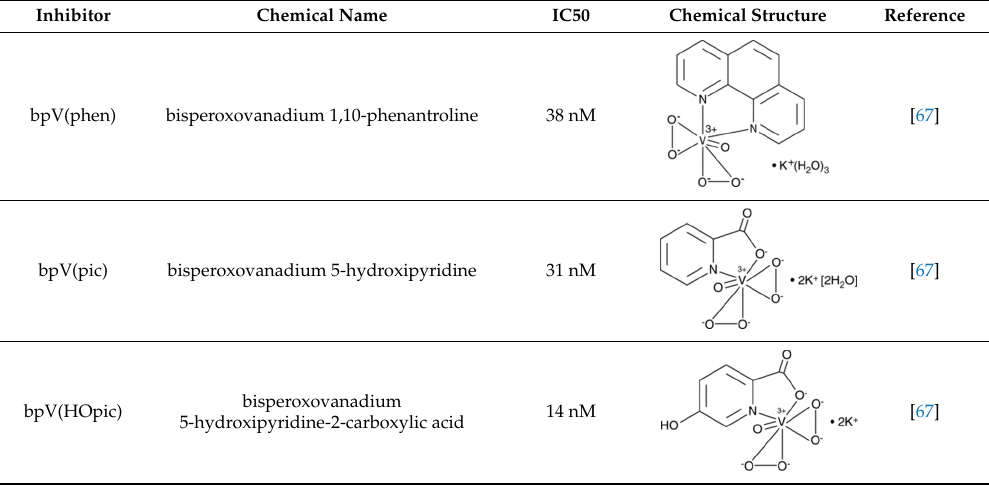
Figure 2. Significance of PTEN inhibition in human disease therapy. Human diseases which could benefit from PTEN pharmacologic inhibition are indicated (see text for a more comprehensive description). Note that the potential beneficial effect of PTEN inhibition has been related with PTEN PI(3,4,5)P3 lipid phosphatase activity. Whether PTEN inhibition may be beneficial in some conditions in relation to PTEN protein phosphatase activity needs to be explored. Table 2. PTEN inhibitors 1 .